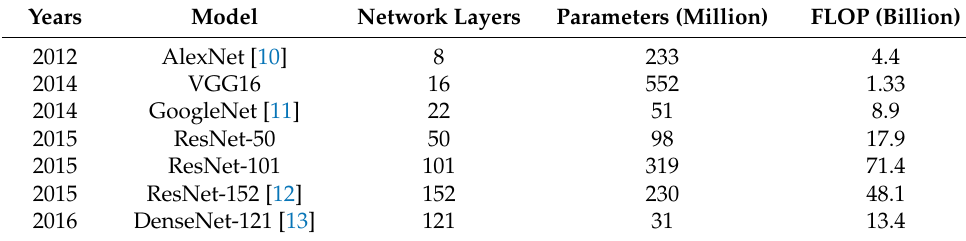
Table 1. Classical network model